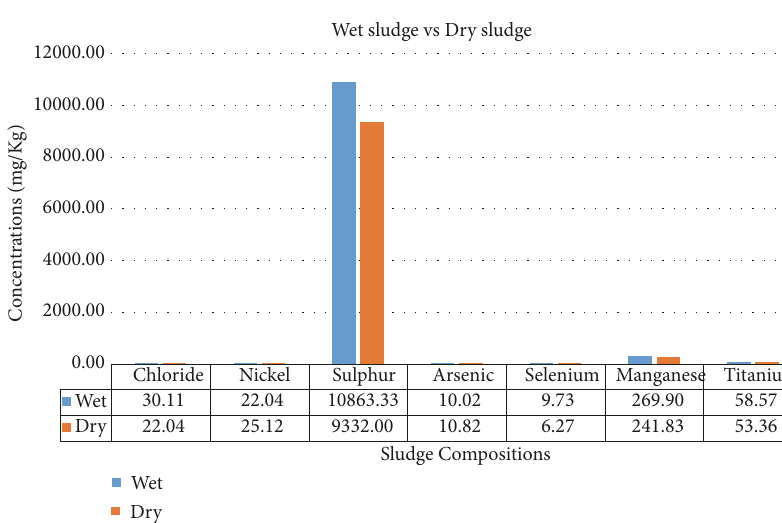
Figure 3: A graph of sludge composition with the state (wet or dry) having no particular effect.